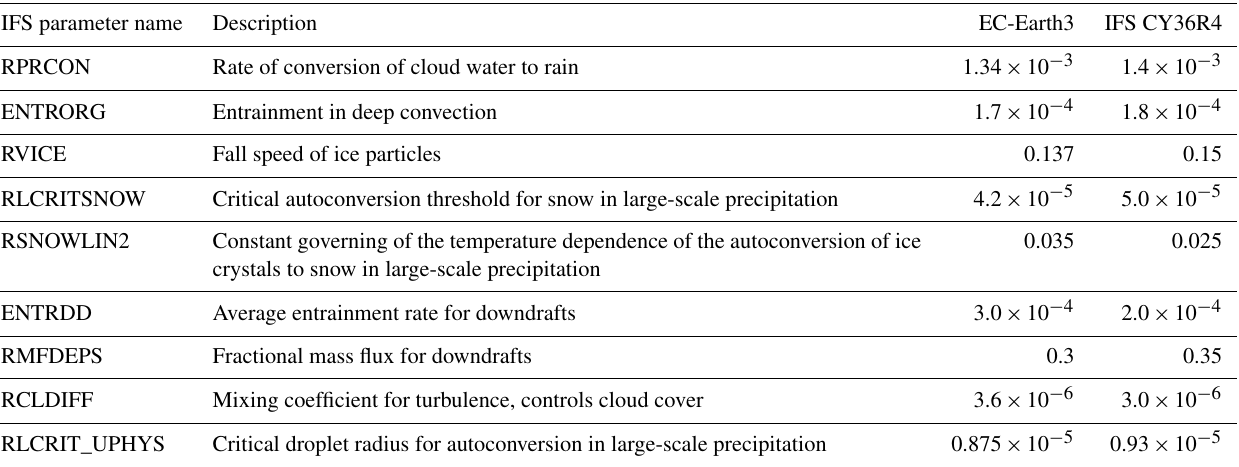
Table 6. Atmospheric tuning parameters changed in EC-Earth compared to IFS CY36R4. The table reports the new values adopted for T255L91 EC-Earth3 and EC-Earth3-Veg